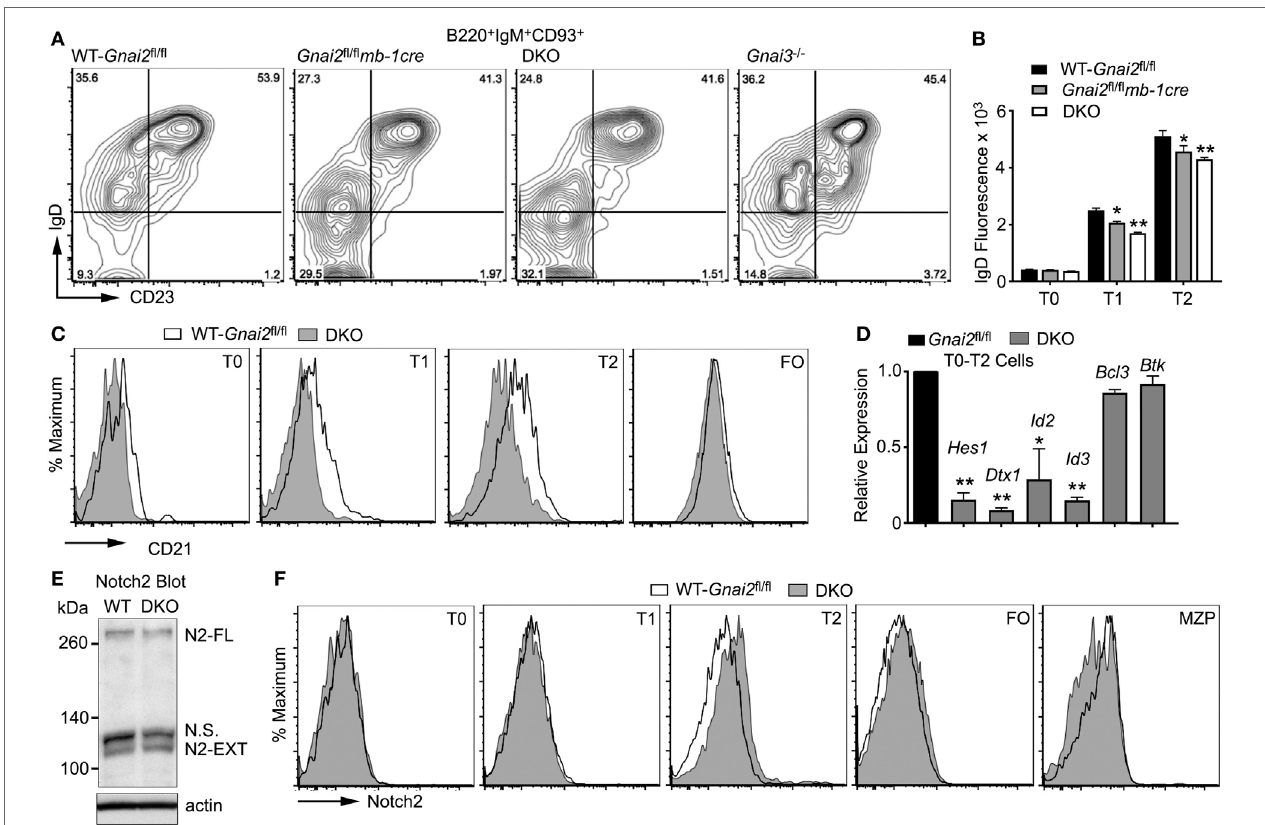
FigUre 2 | Impaired Notch signaling, but unaltered Notch2 receptor expression in G α i -deficient B cells. (a) Flow cytometry of splenic B cells from the indicated mice gated on B220 + IgM + CD93 + for their expression of IgD versus CD23 to distinguish transitional B cell type 0 (T0), transitional B cell type 1 (T1), and transitional B cell type 2 (T2) cells. Results representative of four mice of each genotype. (B) Flow cytometry to determine IgD expression on WT, G α i2 , and G α i2/3 -deficient T0, T1, and T2 transitional cells. Splenic B cells prepared from WT, Gnai2 fl/fl mb1-cre , and double knockout (DKO) mice were analyzed for B220, CD93, IgM, IgD, and CD23 expression. Results from the analysis of three mice of each genotype. Mean fluorescence data are shown as the mean ± SEM of the relative expression of each gene over control cells for the indicated subset (** p < 0.005, * p < 0.05). (c) Flow cytometry showing CD21 expression on WT ( Gnai2 fl/fl ) and DKO transitional, and FO B cells. Results are representative of six or more mice of each genotype. (D) RT-PCR analysis of splenic B cells from WT and G α i -deficient mice. Expression levels of the indicated gene were assessed in mRNA extracted from B220 + IgM + CD93 + cells sorted from control ( Gnai2 fl/fl ) and DKO mice. The results are from two controls versus two DKO. Experiment repeated twice with a similar result. Data shown are the mean ± SEM of the relative expression of each gene over control cells for the indicated subset (** p < 0.005, * p < 0.05). (e) Immunoblot of Notch2 in WT ( Gnai2 fl/fl ) or DKO B cell lysates. Experiment performed twice with a similar